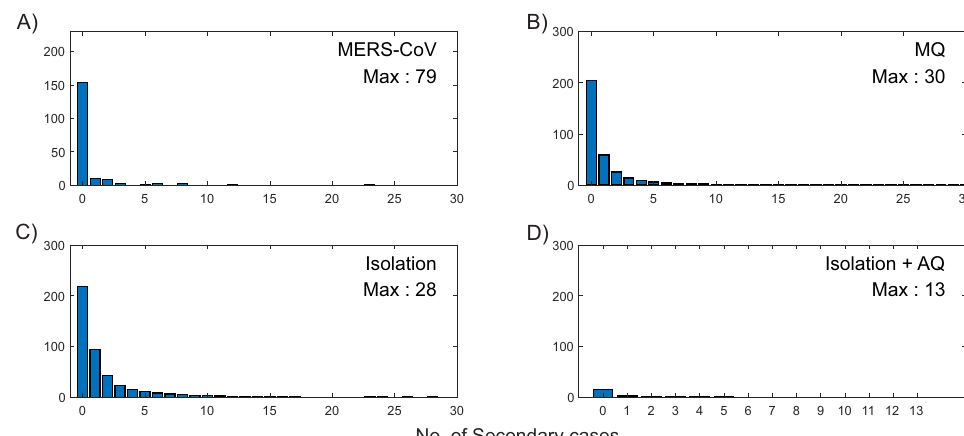
Figure 7. Distribution of secondary cases in actual MERS-CoV data is shown in ( A ). Distribution of secondary cases under the three different interventions are shown in ( B – D